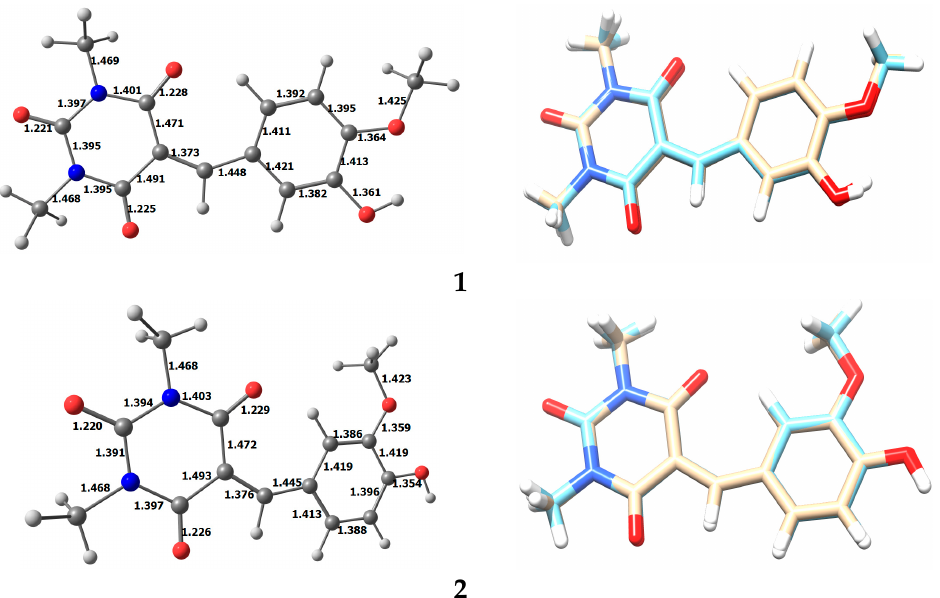
Figure 3. The optimized structures ( left ) and comparative overlay of the calculated and experimental structure ( right ). Bond distance values are given in Å.